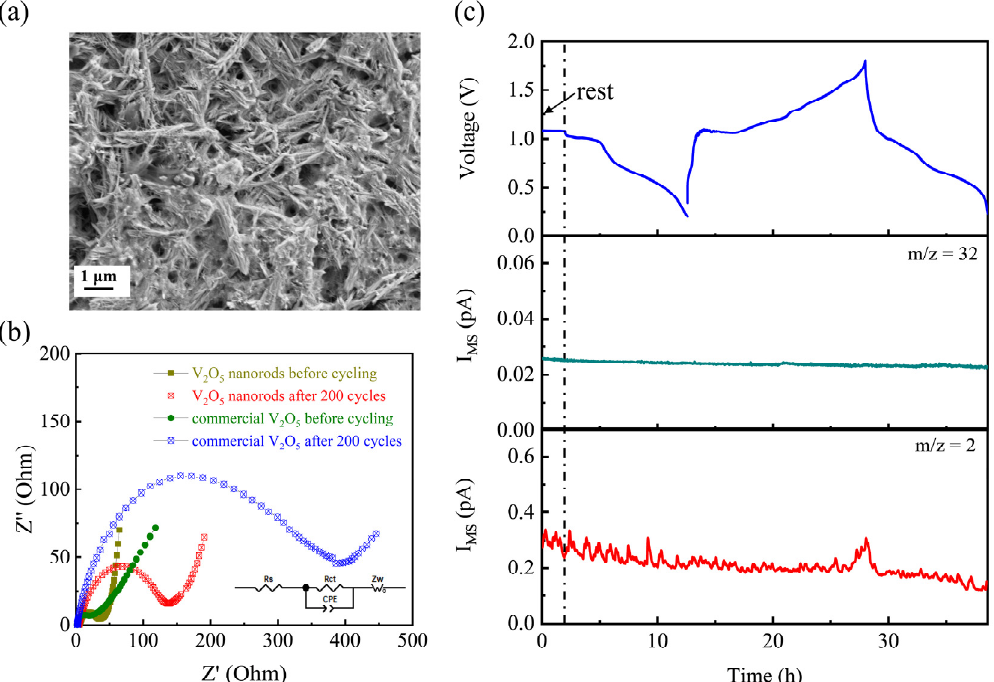
Figure 5. ( a ) SEM image of the cycled electrode after 200 cycles. ( b ) Nyquist plots of the commercial V 2 O 5 powder and V 2 O 5 · n H 2 O nanorod electrodes before and after cycling. ( c ) Online DEMS data for Zn/ V 2 O 5 · n H 2 O cell in 3 m ZnSO 4 aqueous electrolyte in the voltage window of 0.2–1.8 V.